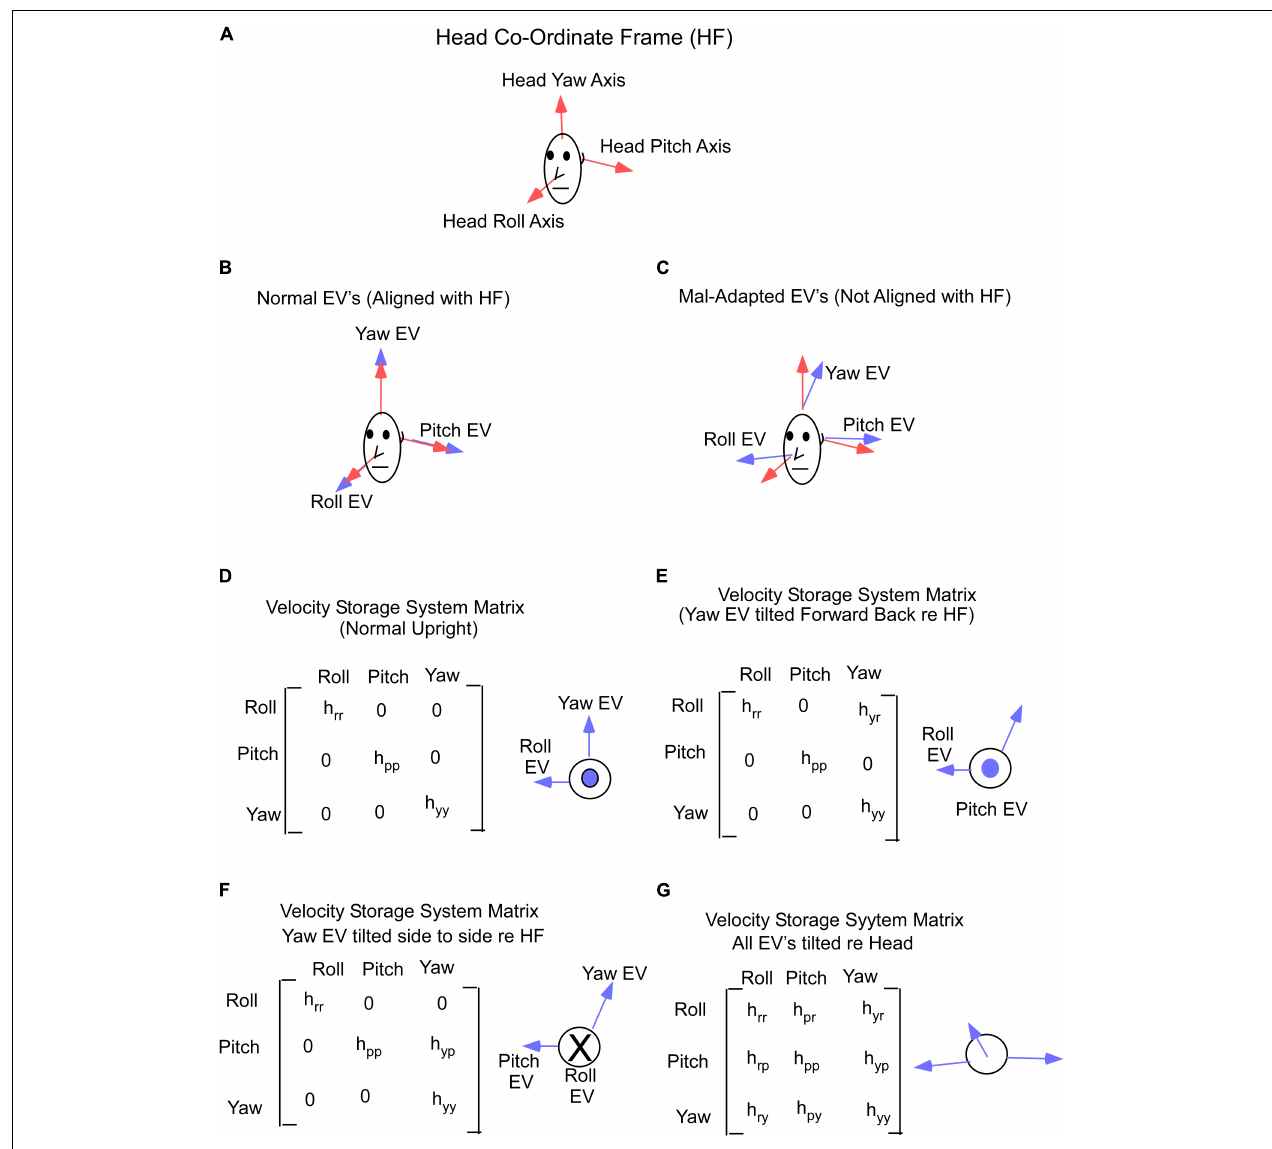
FIGURE 4 | (A) Head coordinate frame used in this study. (B) Yaw, pitch and roll eigenvectors in normal non-adapted states and are aligned with the head axes. (C) Yaw, pitch and roll eigenvectors shifted from their normal orthogonal orientations due to maladaptation of the velocity storage system matrix. (D) Gain matrix of velocity storage in normal state, when yaw, pitch, and roll eigenvectors are aligned with the head axes. (E,F) Gain matrix of velocity storage with yaw eigenvector shifted forward (E) or sideways (F) . (G) Gain matrix of velocity storage when all 3 eigenvectors are shifted from their normal (D) orientations. Insets in (D–G) on the right from gain matrices are a top view of the head. EV –